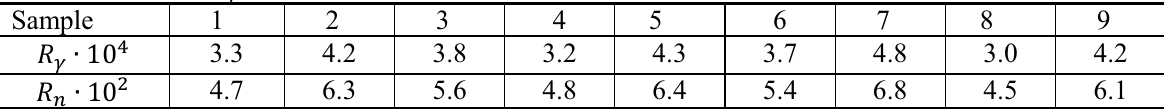
Table 2. Values of (cid:17)